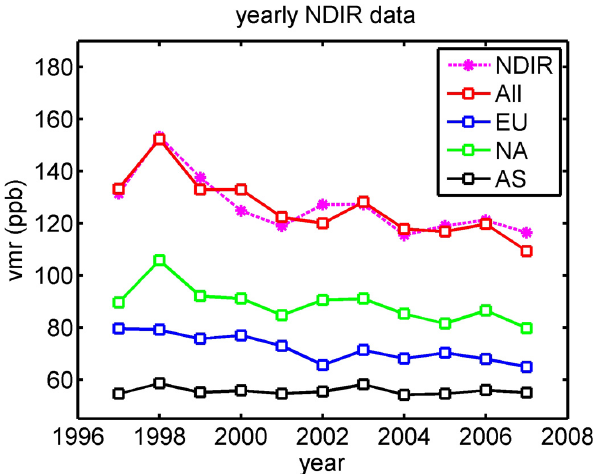
Fig. 12. Yearly mean FTIR data as well as model simulated CO con- centrations above the Jungfraujoch. All, corresponds to the global model simulations, while EU, NA and AS are the model contribu- tions from Europe, North America and Asia respectively. Again the fitted 43ppb background has been added to all model output (also the regional